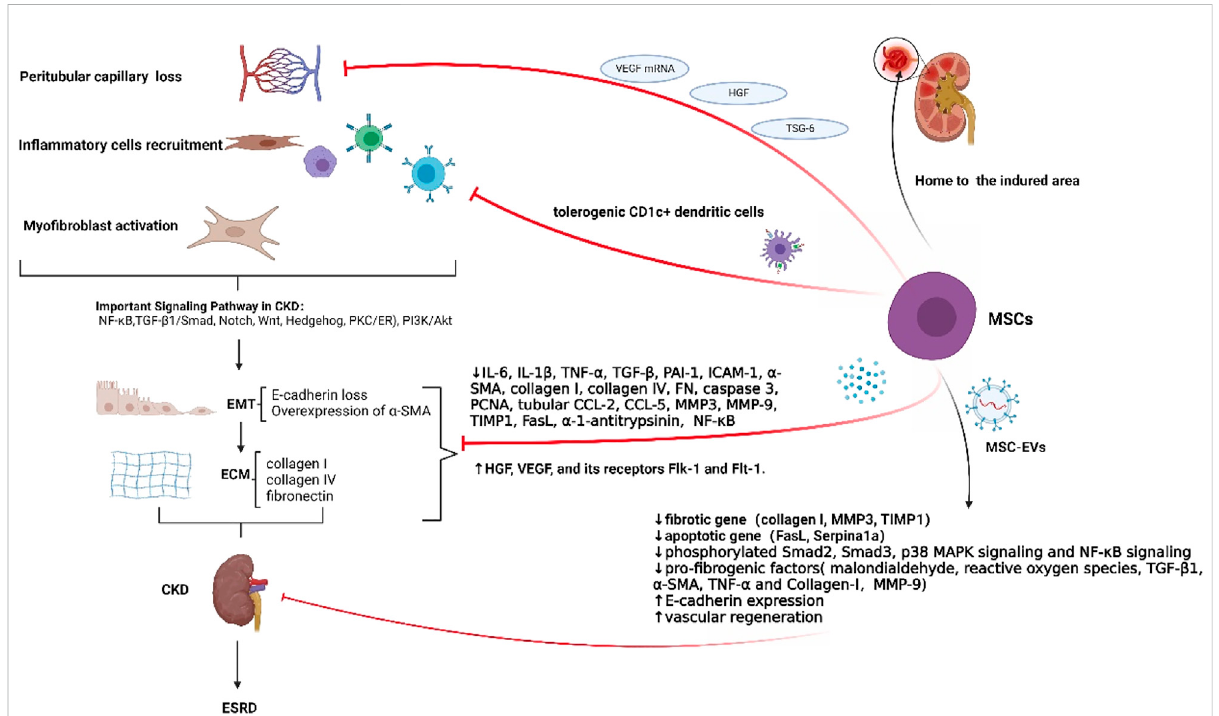
ThepathologicalfeaturesofCKDandthefunctions ofMSCsinCKD.Renal fi brosisisade fi ningfeatureofCKD.Importantpathologicalchanges, in the development of CKD, include the loss of peritubular capillaries, recruitment of in fl ammatory cells, activation of myo fi broblasts, EMT, and ECM deposition. EMT is primarily induced by TGF- β 1. Essential markers of EMT include the overexpression of α -SMA and the loss of E-cadherin. Overexpressionof fi bronectin,collagenI,andcollagenIVisacomponentofECMdeposition.CKDisintimatelyassociatedwithseveralsignaling networks, including TGF- β , MAPK, Wnt/ β -catenin, PI3K/Akt, JAK/STAT, and Notch pathways. In most individuals, multidrug treatment cannot stop theprogressiontowardESRD.MSCscouldreachtheinjuredareatoexertrenalprotectiveeffects.Indetail,MSCscouldgenerateVEGFmRNA,which stops the loss of peritubular capillaries. Also, as paracrine factors of MSCs, HGF and TSG-6 could help to reduce peritubular capillaries. Furthermore, MSCs may reduce in fl ammation by promoting tolerogenic CD1c+ dendritic cells, which can inhibit T cell proliferation and differentiation. Moreover, MSCscoulddiminishEMTandrenal fi brosis,byloweringlevelsofIL-6,IL-1 β ,TNF- α ,TGF- β ,PAI-1,ICAM-1, α -SMA,collagenI,collagenIV,FN,caspase 3,PCNA,tubularCCL-2,CCL-5,MMP3,MMP-9,TIMP1,FasL, α